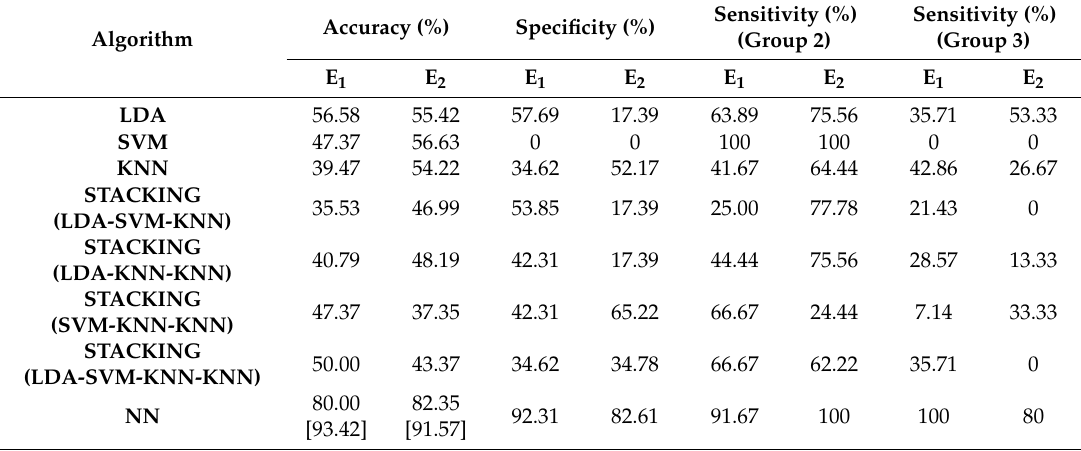
Table 5. Classification accuracies, specificities, and sensitivities obtained for each of the machine learning algorithms for both experiments. In the case of neural networks, the accuracy is determined Table 6. Confusion matrix for the final classification model of Figure 4. using 20% of the dataset for validation and the between-brackets accuracy is determined using 100% of the dataset.